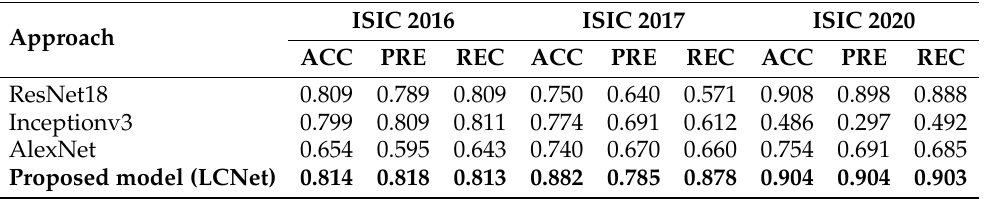
Table 8. A comparison between proposed LCNet with baseline CNN models on the ISIC 2016, 2017, and 2020